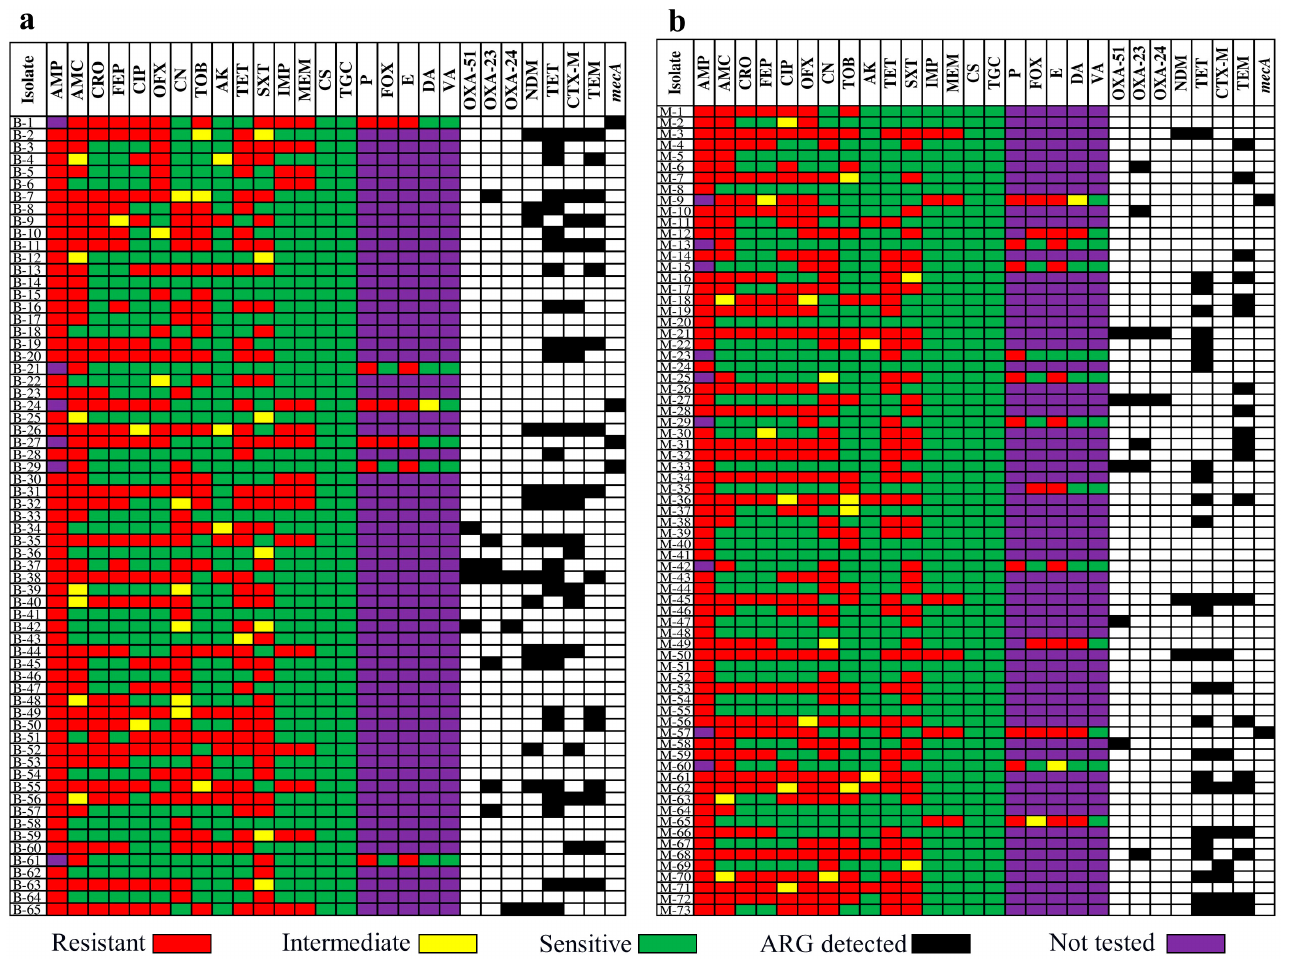
Figure 3. Coexistence of antimicrobial resistance (AMR) and antimicrobial resistance genes (ARGs) in different isolates. ( a ) AMR and AMGs in bacterial isolates of bovine. ( b ) AMR and AMGs in bacterial isolates of milk.